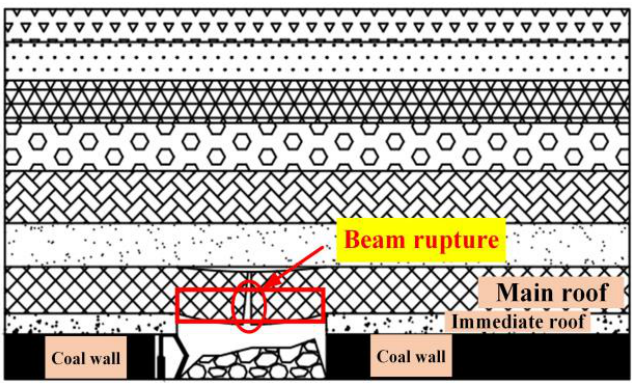
Figure 3. Periodic weighting. Figure 2. First weighting. Figure 2. First